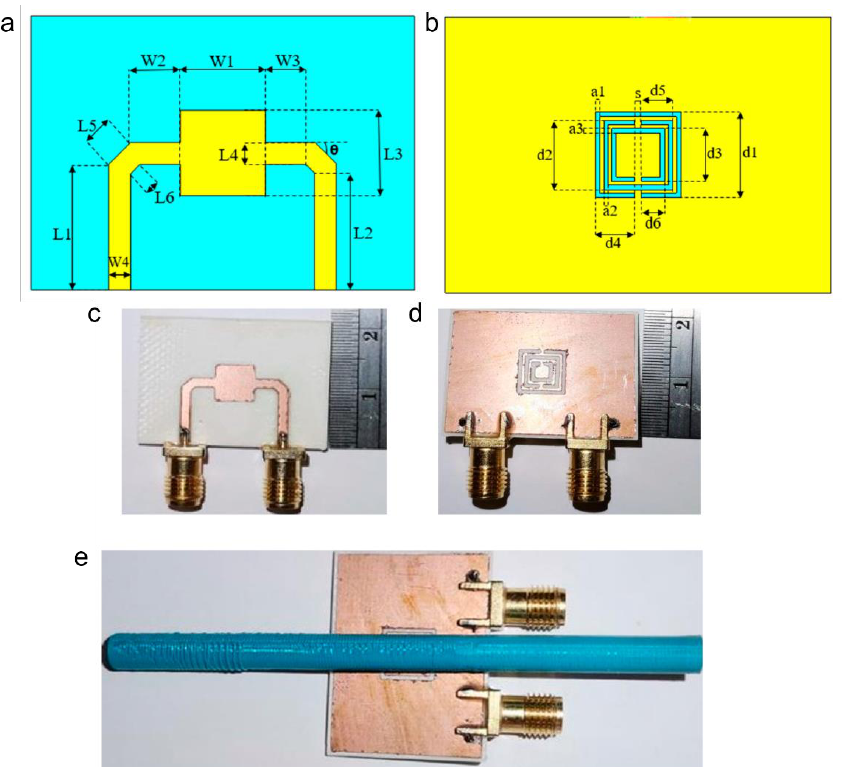
Figure 12. Geometric dimensions of the flat sensor structure ( a ) top view; ( b ) bottom view. S21 parameter simulations. Fabricated sensor prototype: ( c ) top view; ( d ) bottom view; ( e ) flat sensor with embedded tube [129] Copyright: © 2022 MDPI.